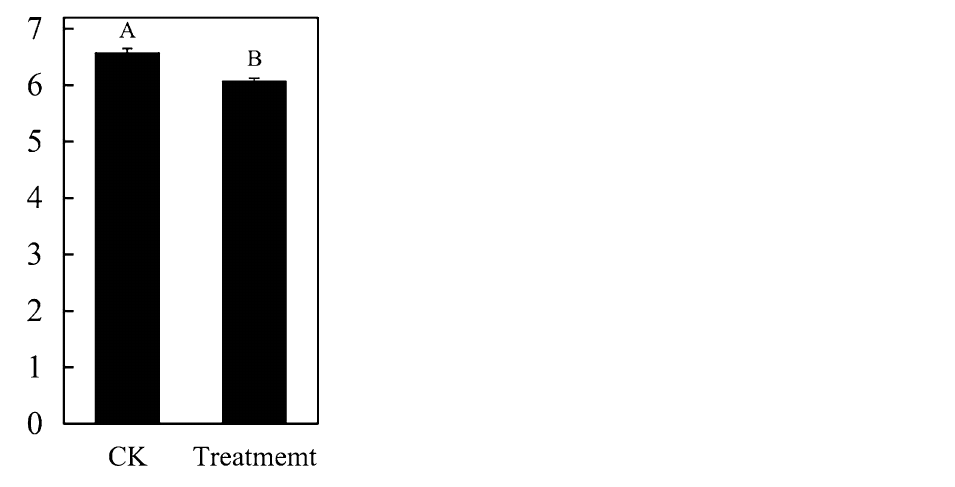
Figure 16. The pH of consolidated soil